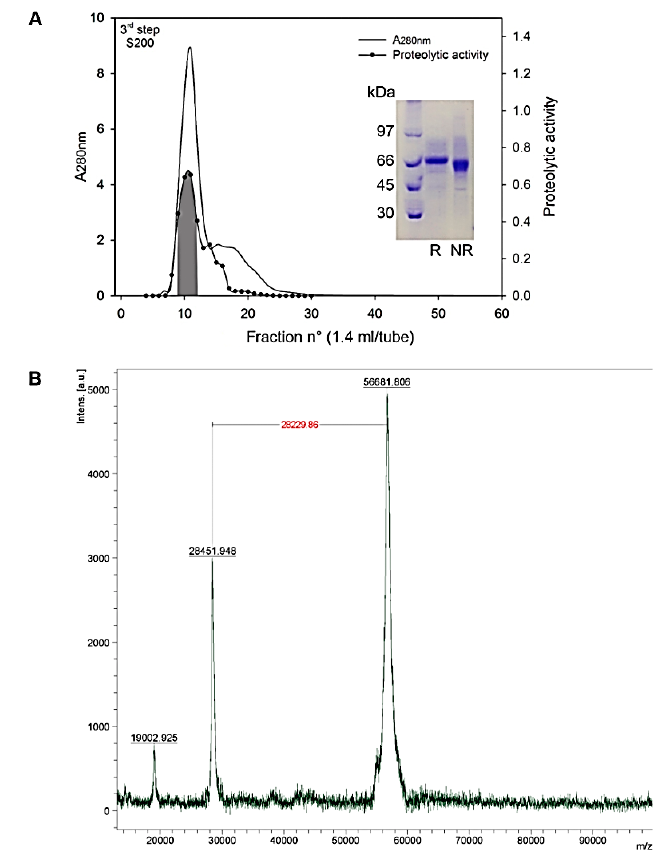
Figure 1. Purification of Atroxlysin-III from B. atrox venom (3rd step). ( A ) Fraction from the second step (DEAE-ion exchange column) containing hemorrhagic activity was applied to a Sephacryl 200 column. The column was equilibrated and eluted with 50 mM Hepes buffer, pH 8.0, containing 0.1 M NaCl, 2 mM CaCl 2 at a flow rate of 3.4 mL/h. Active fractions containing Atr-III were pooled (area under curve highlighted in grey). The inset indicates the SDS-PAGE (12% gel) of purified Atr-III under reduced (R) and non-reducing (NR) conditions. ( B) Mass spectrometry of native Atr-III. Purified Atr-III was analyzed by MALDI TOF/TOF. The main signal (displayed in arbitrary units—a.u.) corresponded to a singly charged ion of 56,681.8 daltons.